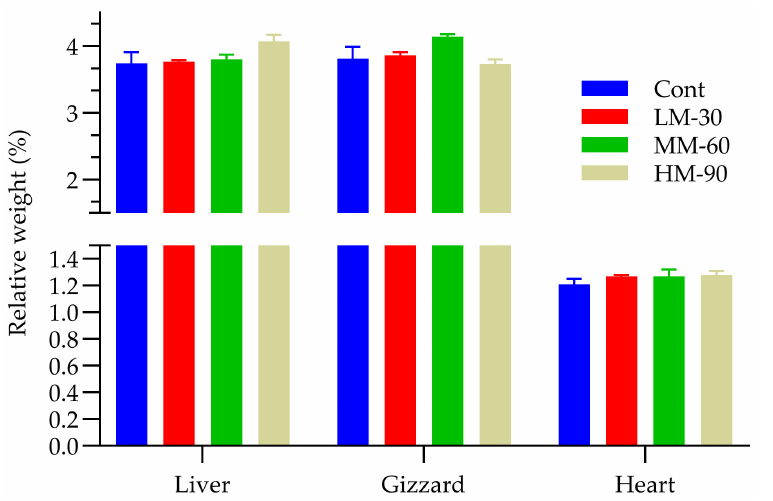
Figure 3. Effect of β -mannanase supplementation on organ indexes in broilers fed low energy diets. Cont (ME 3100 kcal/kg): without β -mannanase; LM-30 (ME − 30 kcal/kg), MM-60 (ME − 60 kcal/kg) and HM-90 (ME − 90 kcal/kg) were supplemented with 200, 400, and 600 mg/kg β -mannanase,